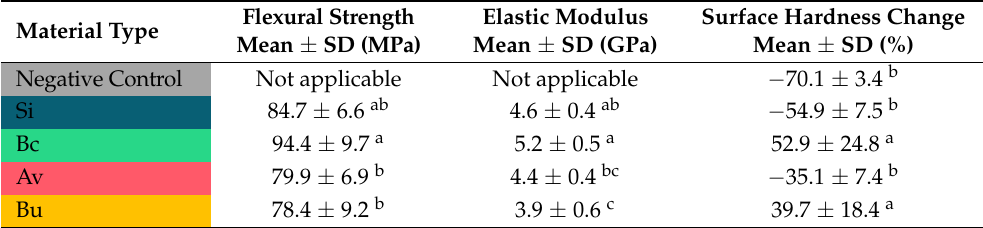
Values indicated by different letters (a, b, c) are statistically significant and different from each other ( p <